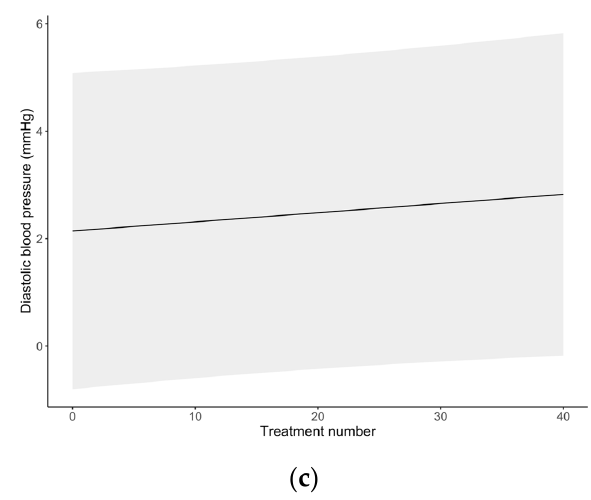
Figure 1. Temporal changes of arterial blood pressure over the total number of HBOT sessions. ( a ) Mean arterial pressure; ( b ) systolic arterial pressure; ( c ) diastolic arterial pressure. Mean post-session ABP values at each session are represented by a point. The shaded area represents the 95% confidence interval. Table 3. Temporal dynamics in arterial blood pressure measurements before and after HBOT sessions (entire HBOT course) in patients with or without the history of hypertension.